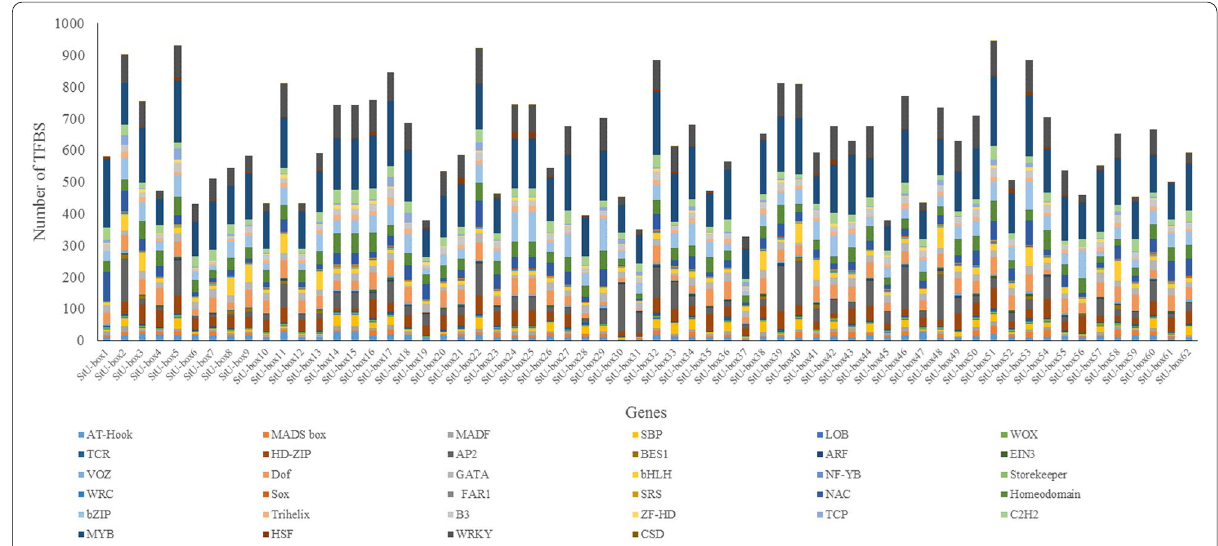
Fig. 5 TFBS distribution in promoter regions of StU-box gene